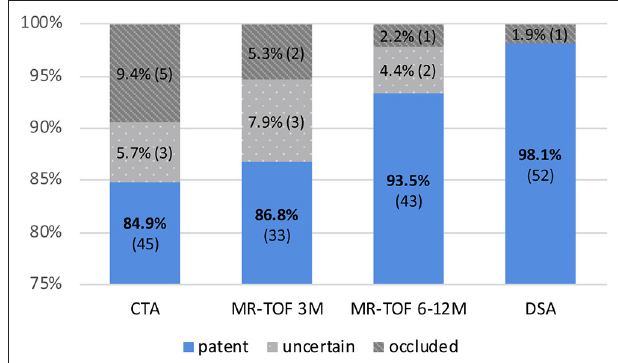
FIGURE 1 | Percentage and number of bypasses shown as “patent,” “uncertain,” and “occluded” in CTA post-operatively, MR-TOF after 3 months (3M), MR-TOF after 6 to 12 months (6–12M) and DSA after 6 to 12